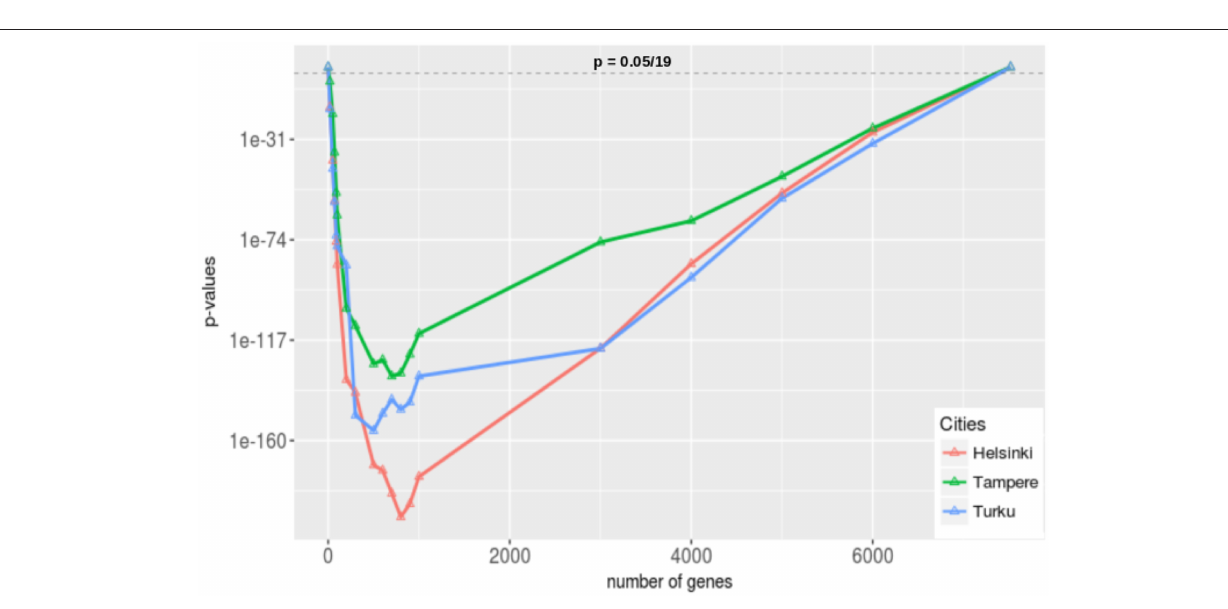
to Table 1 , Henslinki, Tampere, and Turku. The horizontal dashed line corresponds to the significance level of α